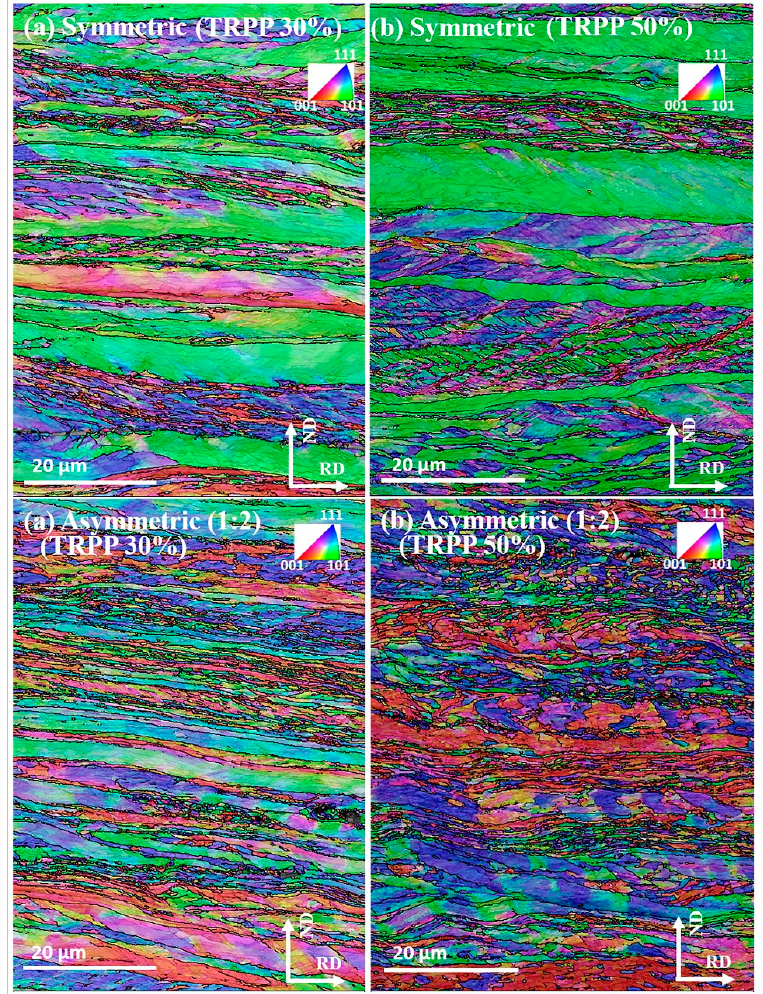
Figure 11. IPF maps (RD axis projection) for high strain (89%) rolled in symmetric and asymmetric (1:2) mode with TRPP of ( a ) 30% and ( b ) 50%.